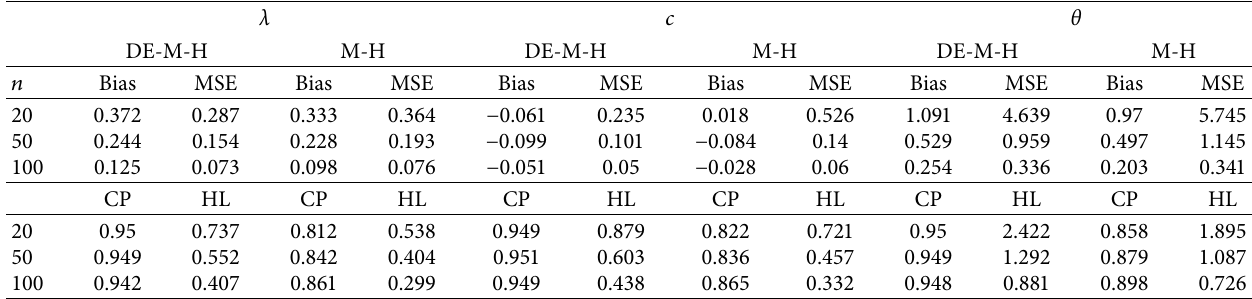
Table 8: Bias, MSE, coverage probability (CP), and half length (HL) of the Bayesian estimates based on DE-M-H and RW-M-H algorithms when λ � 0 . 5, c � 0 . 5, and θ � 1 .